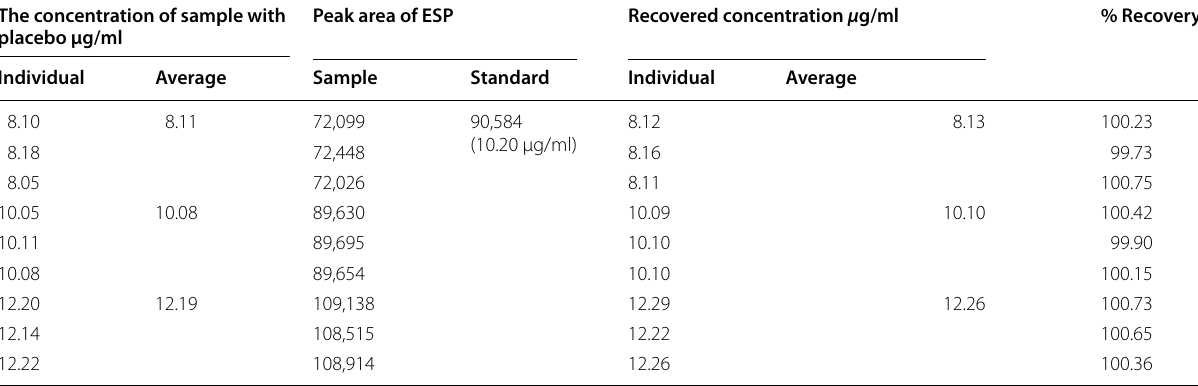
Table 5 Data of accuracy with placebo for recovery analysis for ESP